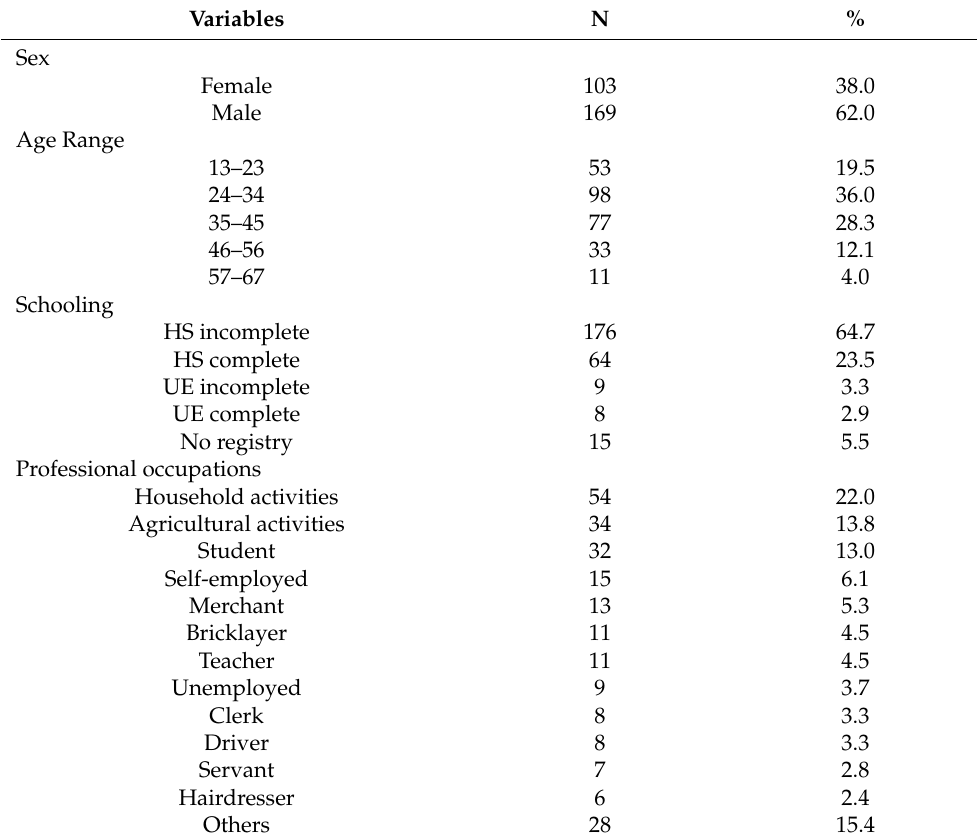
Table 1. Sociodemographic profile of patients with cryptococcosis, 2008–2018, JBBUH, Par á , Brazil.